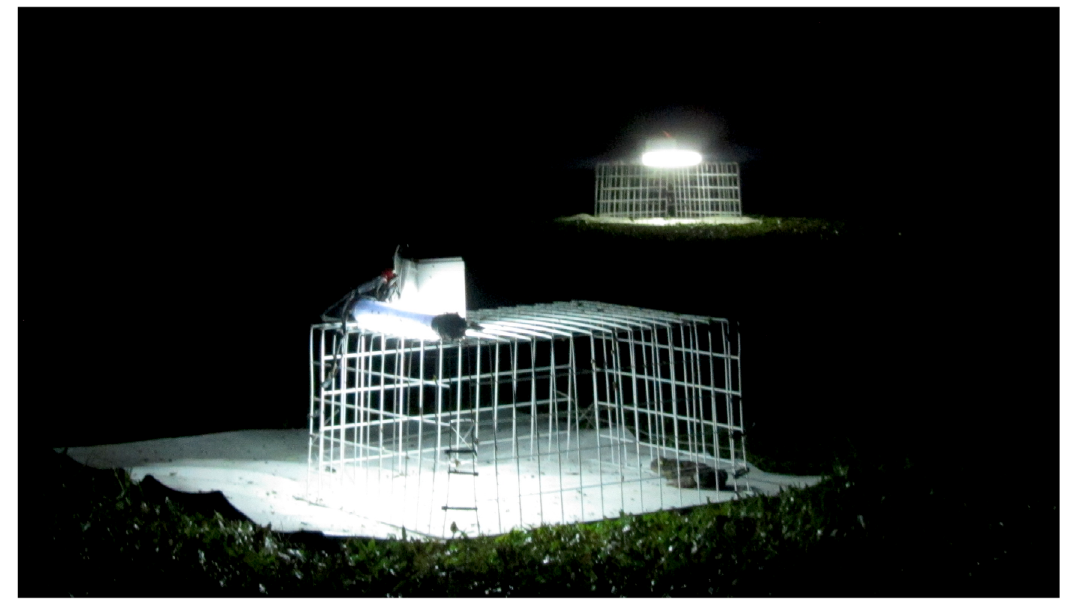
Figure 1. Experimental feeding-stations. Stations used to test the effects of conspecific presence on feeding responses of free-ranging cane toads. Note the captive toad in the foreground, providing a social stimulus.